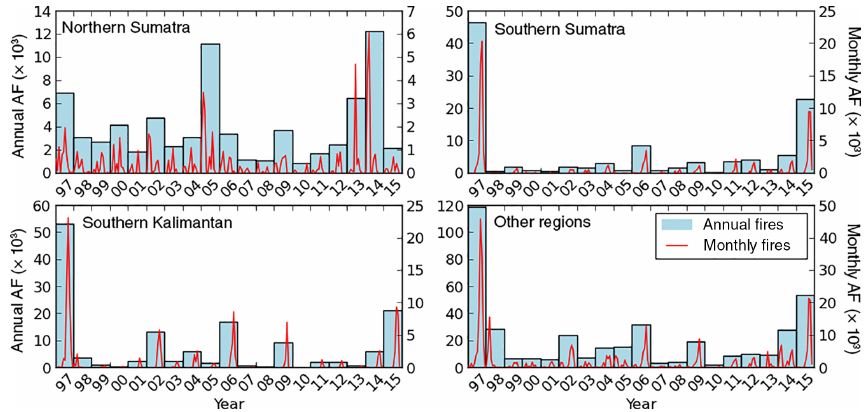
Figure 5. Number of annual (blue bars, left axis) and monthly (red line, right axis) active fire (AF)